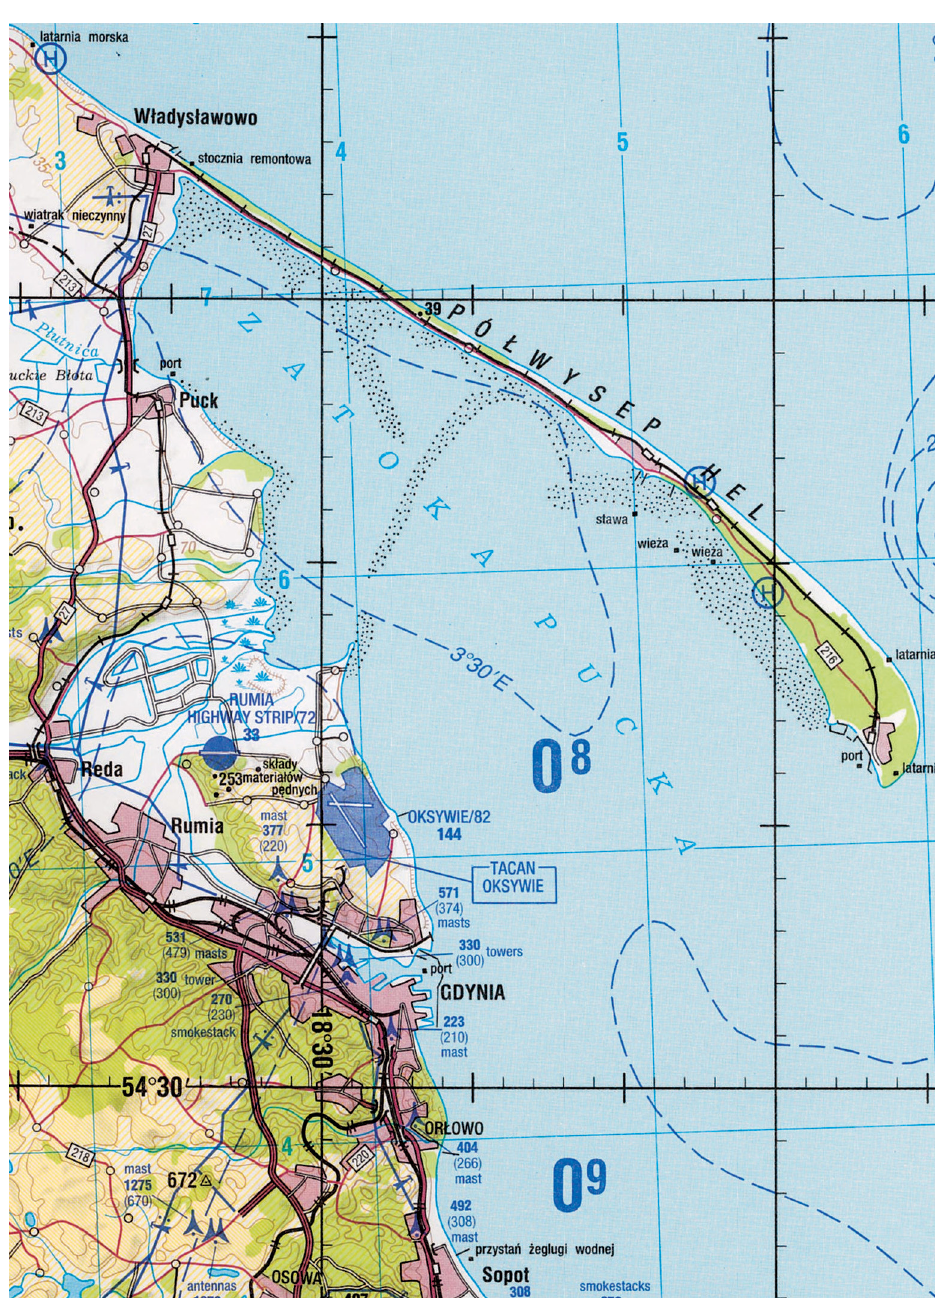
Fig. 12. Joint Operations Graphic , 1:250,000 – 1501 AIR